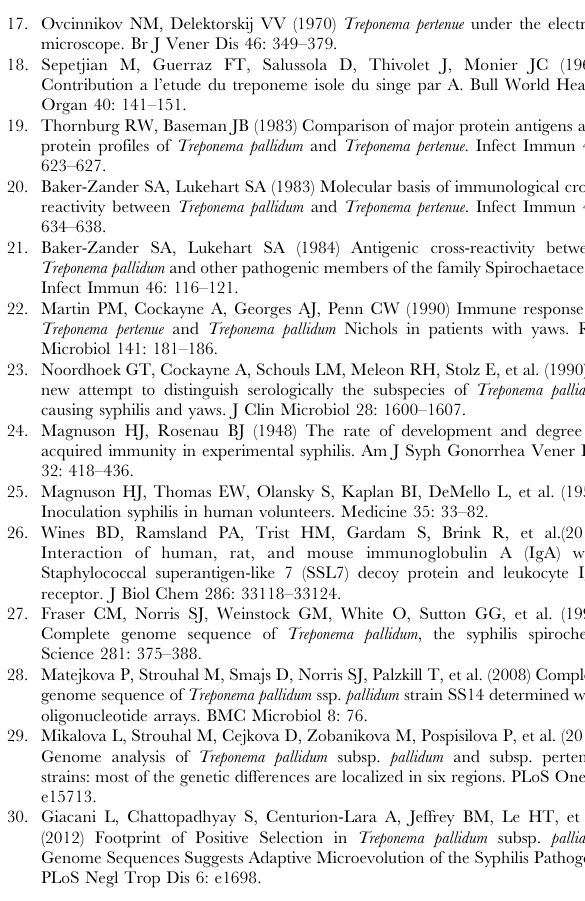
Figure S1 Predicted full length amino acid and DNA sequence alignments of the tpr gene family by locus. For the ORFs containing indels resulting in frameshifts and truncated proteins, only the encoded amino acid sequences before the premature stop codon are shown. In tprD locus, tprD2 alleles were excluded for clarity purposes only. In tprG locus, because of the significant dissimilarities among sequences, alignments are sepa- rated in two groups: GI and GJ chimeras. Red font, T. p. pallidum subspecies; blue T. p. pertenue ; bright green, T. p. endemicum ; yellow, the Simian treponeme; and pink, T. paraluiscuniculi .